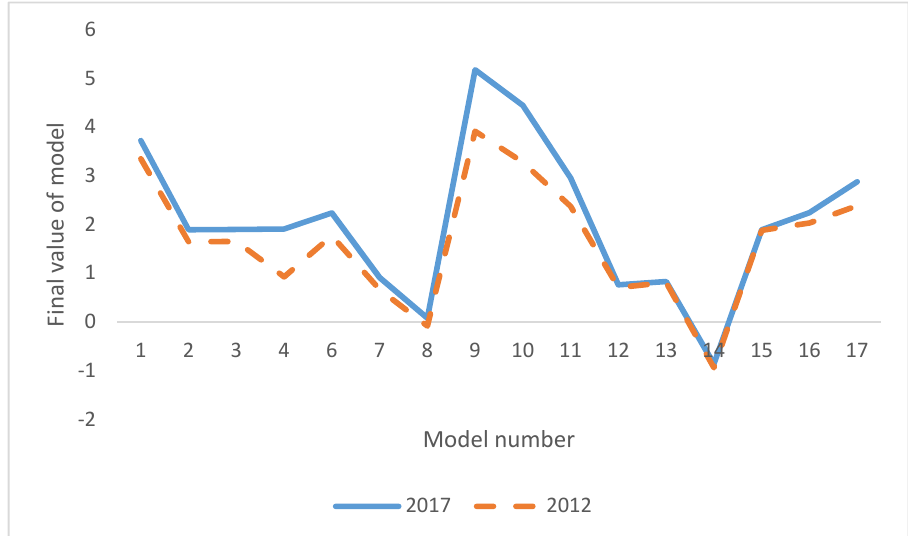
Figure 1. Indicator values of the studied models for healthy companies in Construction (CZ-NACE F). Source: authors’ own work.